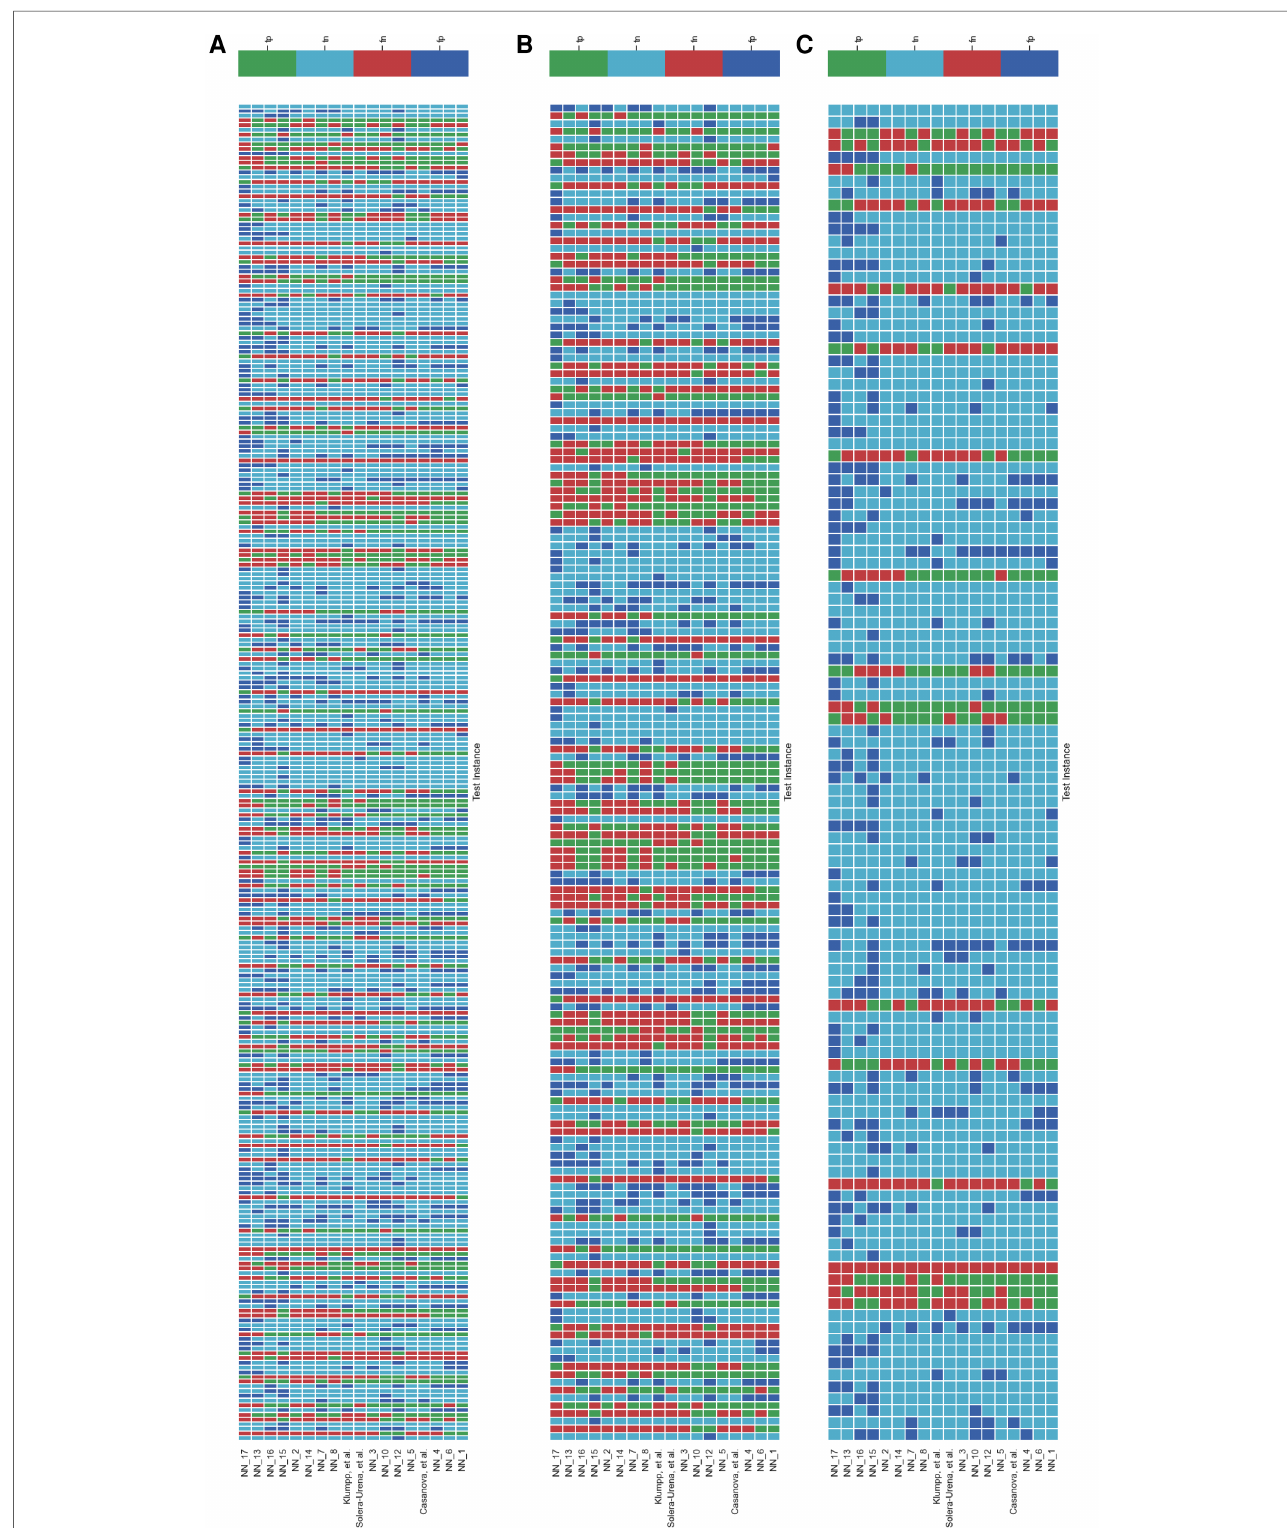
FIGURE 6 Schematic detailing the level of agreement between teams for each test instance for the COVID-19 Speech Sub-Challenge . Each row represents a team ’ s submission results. The teams have been ordered by Unweighted Average Recall (UAR), from the bottom up (team yoshiharuyamamoto ’ s predictions represent the highest scoring submission). Each column represents all teams ’ predictions, across the competition, for one test instance. The test instances appear in the order which they are in the test set. note: There are more test cases in the COVID-19 Speech Sub-Challenge than in the COVID-19 Cough Sub-Challenge. ( A ) Details all the test instances, ( B ) details only the test instances which were experiencing symptoms at the time of recording, and ( C ) details only the test instances which were experiencing no symptoms at the time of